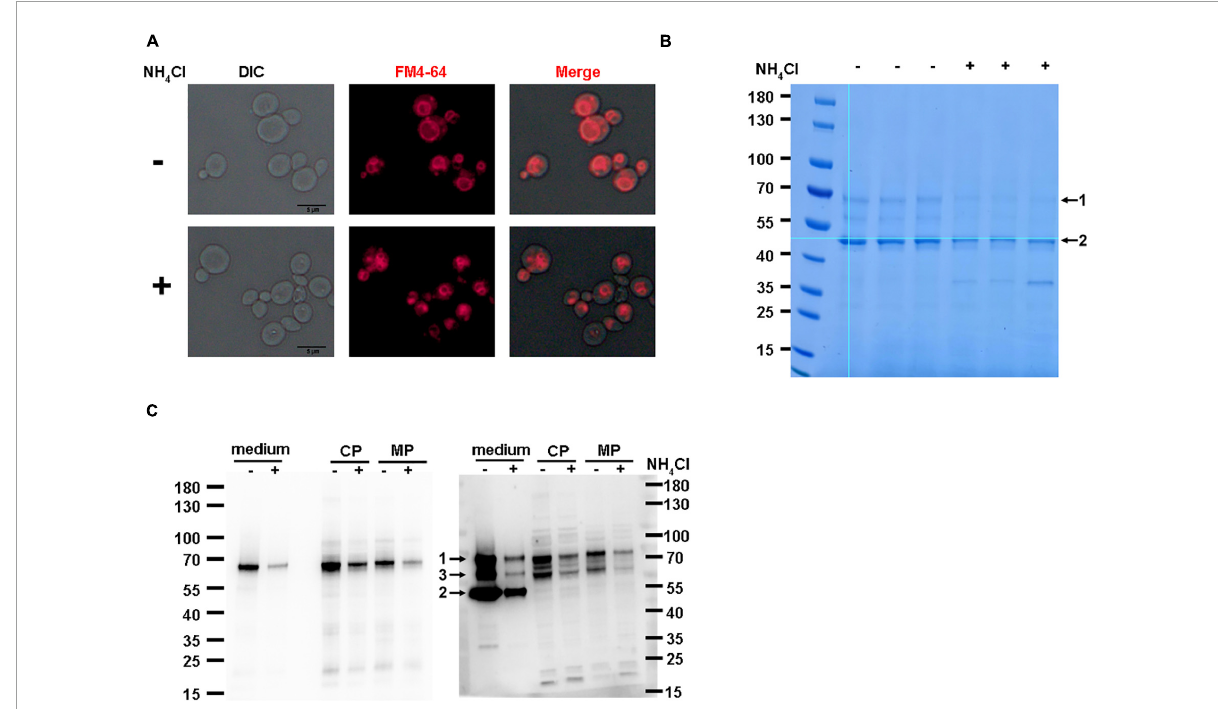
FIGURE7 Effect of NH 4 Cl supplementation on the production of HSA-pFSH β . (A) Effect of NH 4 Cl supplementation on vacuolar morphology in F strain. (B) SDS-PAGE analysis of HSA-pFSH β protein in cells of F strain. Arrow 1 and 2 represent the intact HSA-pFSH β protein and HSA-truncated degradation fragment, respectively. (C) Western blot analysis of HSA-pFSH β protein in cells of F strain. Blots were probed with antibodies specific for mouse 6 × His tag monoclonal antibody (left) and human FSH β monoclonal antibody (right). CP, cytosolic protein; MP, membrane-associated protein. +, represent culture medium supplementing with 0.4 M NH 4 Cl, otherwise marked -. Arrow 3, degraded fragment of HSA-pFSH β